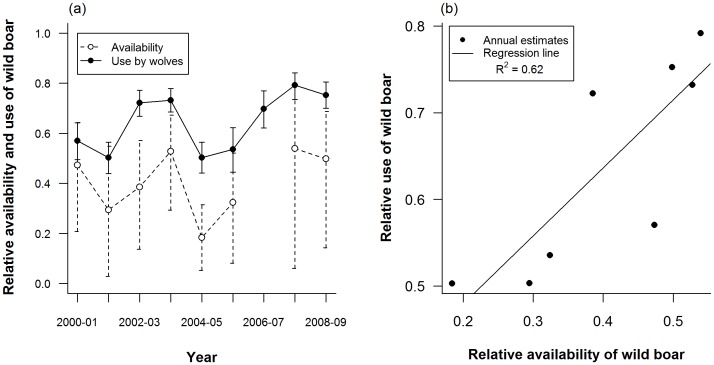
Wild boar use and availability.The relationship between the availability and use of boar (relative to ungulate community including wild boar and roe deer only) is shown. a) Relative availability (grey line, open circles) and relative use (black line, solid circles) was estimated each year from 2000–01 to 2008–09 excluding the year 2006–07. Error bars represent 95% confidence intervals. b) Linear regression analysis was used to illustrate the relationship between the relative availability and the relative use of wild boar across the eight years (solid circles) for which availability was estimated (black line, y = 0.323+0.784x, R2 = 0.621, P = 0.0124).